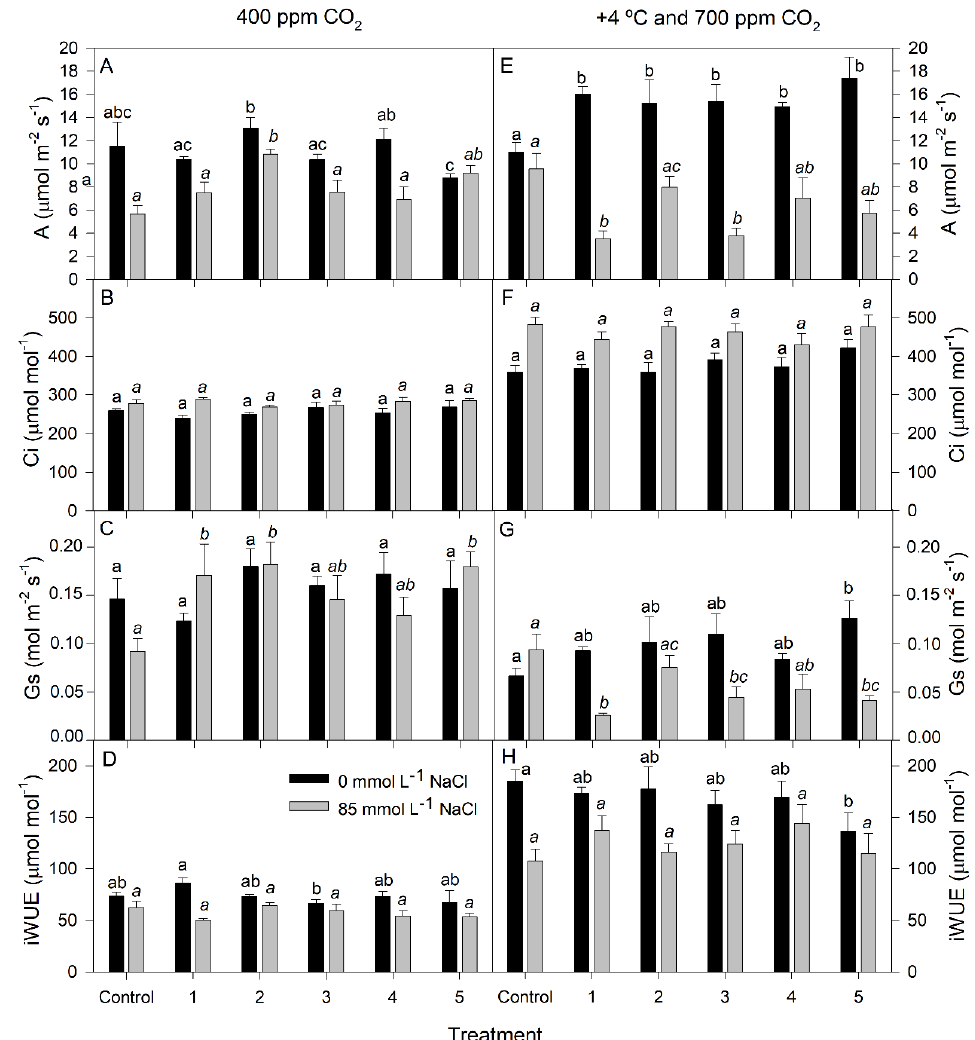
Figure 3. A, net photosynthetic rate ( A , E ); Ci, intercellular CO 2 concentration ( B , F ); Gs, stomatal conductance ( C , G ); and iWUE, instantaneous water use efficiency ( D , H ) of strawberry plants inoculated with rhizobacteria consortia, numbered 1 to 5 (control = non-inoculated plants), after 30 d of treatment at 400 ppm CO 2 ( A – D ) and at +4 °C and 700 ppm CO 2 ( E – H ), with 0 and 85 mmol L − 1 NaCl. Each value represents the mean of eight replicates ± SE. Different letters for each saline treatment (capital and italic letters for 0 and 85 mmol L − 1 NaCl, respectively) indicate those means that are significantly different from each other (GLM; Duncan test, p < 0.05).